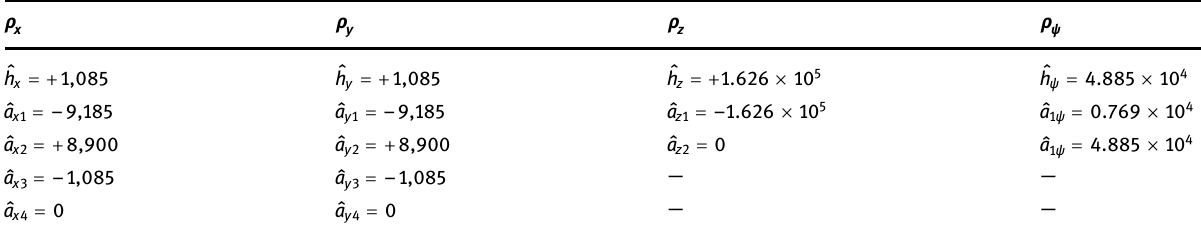
Table 5: Nominal unknown control